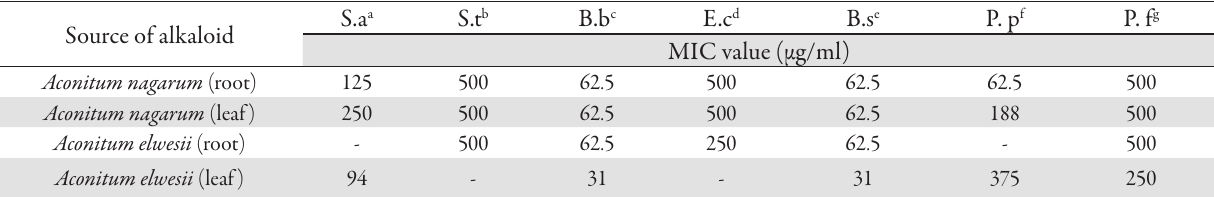
Tab. 5. MIC value of alkaloid extract from Aconitum spp. against different bacteria Source of